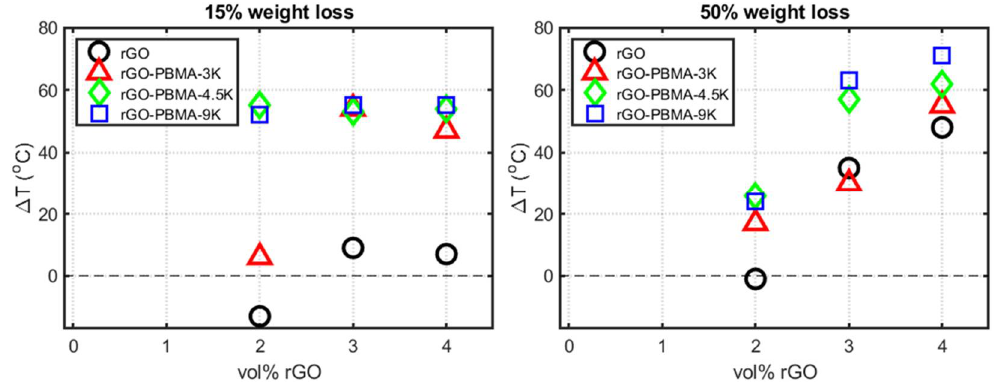
Figure 2. Thermal stability increase versus nanofiller fraction at ( left ) 15% weight loss and ( right ) 50% weight loss. The data are extracted from TGA thermograms.